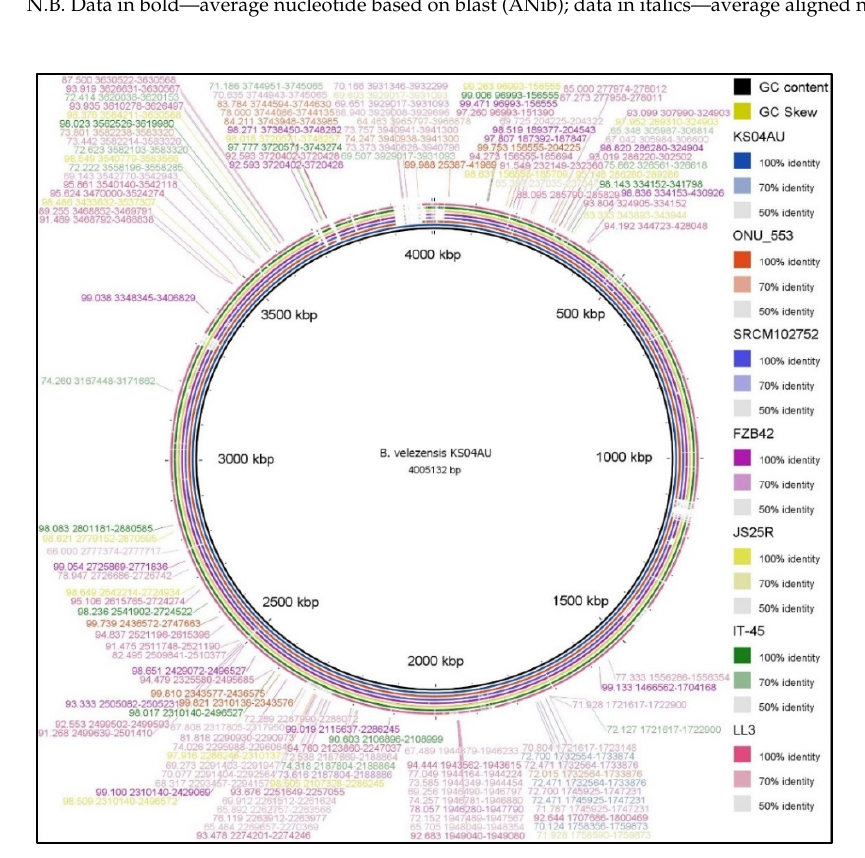
Figure 4. Neighbor-joining phylogenetic tree constructed from 16S rRNA extracted from genomes using the ContEst16S tool. The tree was generated by MEGA 11 using the neighbor-joining method. RAST, the analysis of subsystem distribution followed by comparison among ge- nomes, revealed in the B. velezensis KS04AU genome the presence of 44 genes associated with the control of bacterial mobility and Chemotaxis; 81 genes associated with the cell wall and capsule; 36 genes responsible for virulence, diseases and defense; and 215 for carbohydrates (Figure 5). The KS04AU strain also encodes numerous pathways that are related with the utilization of plant-derived molecules, the production of enzymes, and plant-growth substances. Genes responsible for xenobiotic degradation, such as mem-